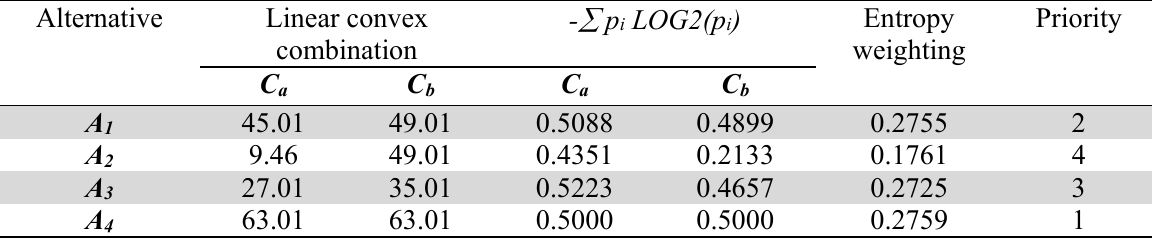
Moderate Entropy Weighting with  -level=0.95